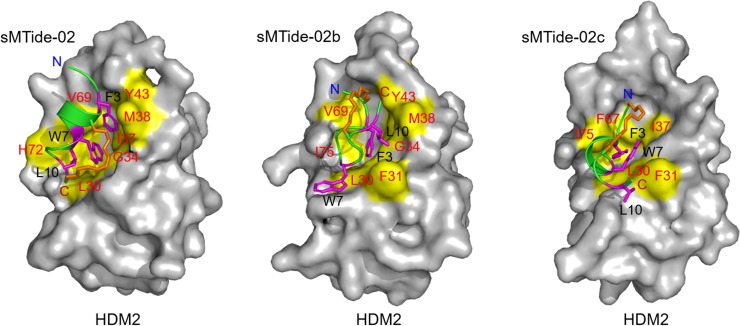
Representative structures of simulated stapled p53/HDM2 complexes.Three epitope residues (F3, W7, and L10; colored magenta) of the stapled p53 peptides are indicated by stick representations. The yellow surface shows the hydrophobic surface (comprising the residues colored red) of HDM2 interacting with the epitope residues.